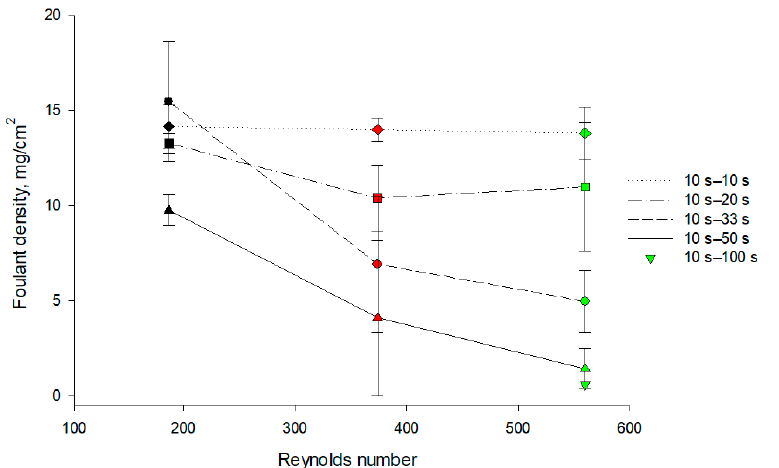
Figure 6. Weight of protein fouling normalized by the effective membrane area (in mg/cm 2 ) recov- ered on the BPM cationic surface in contact with caseinate stream after EDBM depending on the Reynolds numbers in different PEF current modes with pulse–pause durations of 10 s–10 s, 10 s–20 s, 10 s–33 s, 10 s–50 s and 10 s–100 s. Reynolds numbers of 187, 374 and 560 correspond to linear velocities of 7.8, 15.6 and 23.4 cm/s,